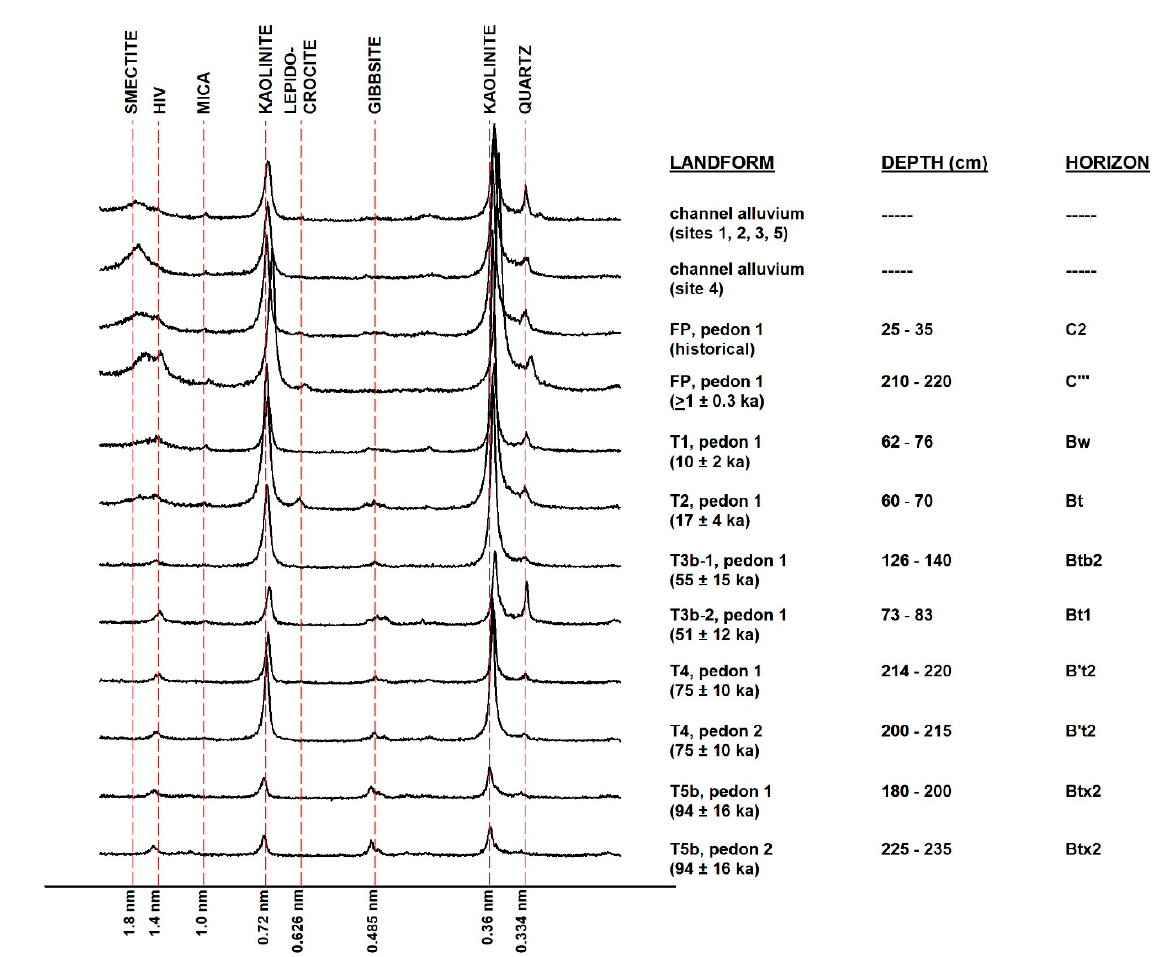
Figure 5. Mineralogy of the <2 µm fraction from the most well-developed subsoil horizon of at least one representative pedon per landform, as indicated by X-ray diffraction (XRD) patterns of Mg-saturated, glycol-solvated clays. HIV = hydroxy-interlayered